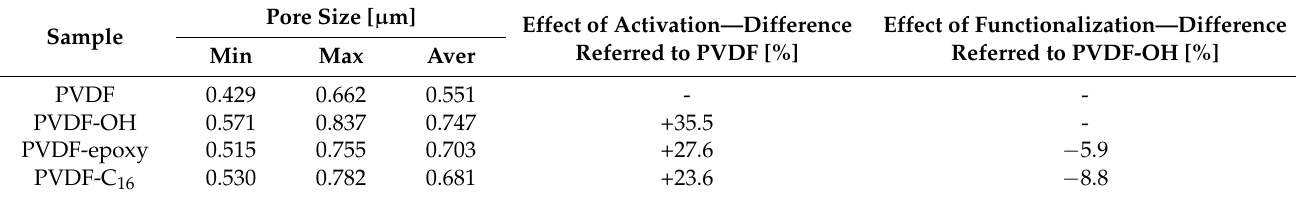
Table 1. Minimum (Min), maximum (Max), and average (Aver) pore size of the investigated membranes with changes relative to the pristine and activated